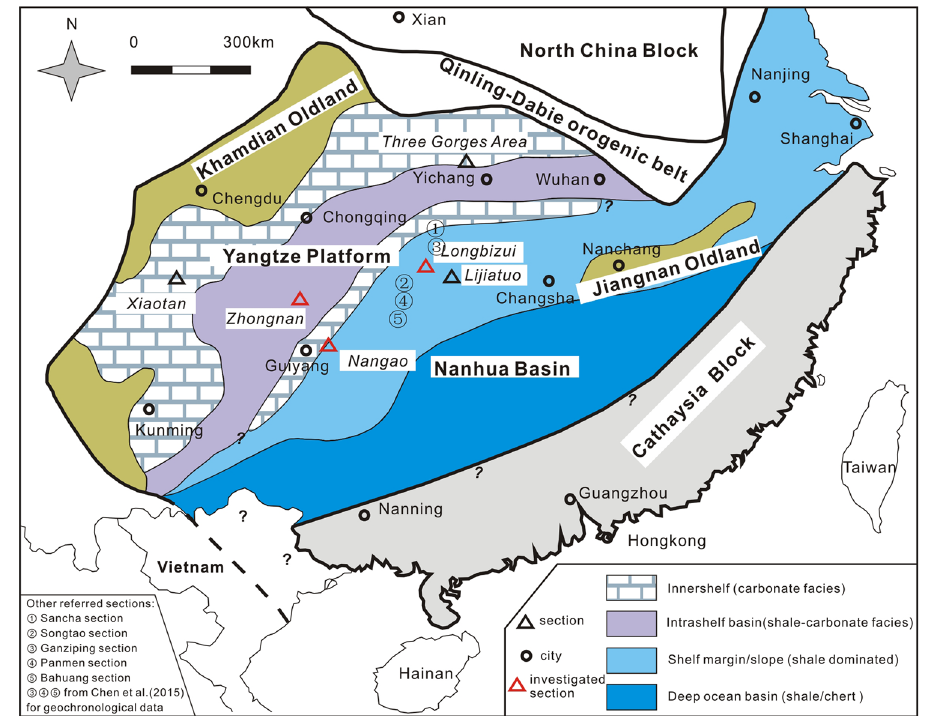
Figure 1. Paleoenvironmental map of the South China Block in the Early Cambrian (after ref. 18, with permission from Elsevier), showing locations of investigated sections. The figure was created by the author and co-authors, with mainly MapGIS 9.0 (http://www.mapgis.com/) constraining the geographic locations and CorelDRAW × 4 (http://www.corel.com/en/) further enhancing this